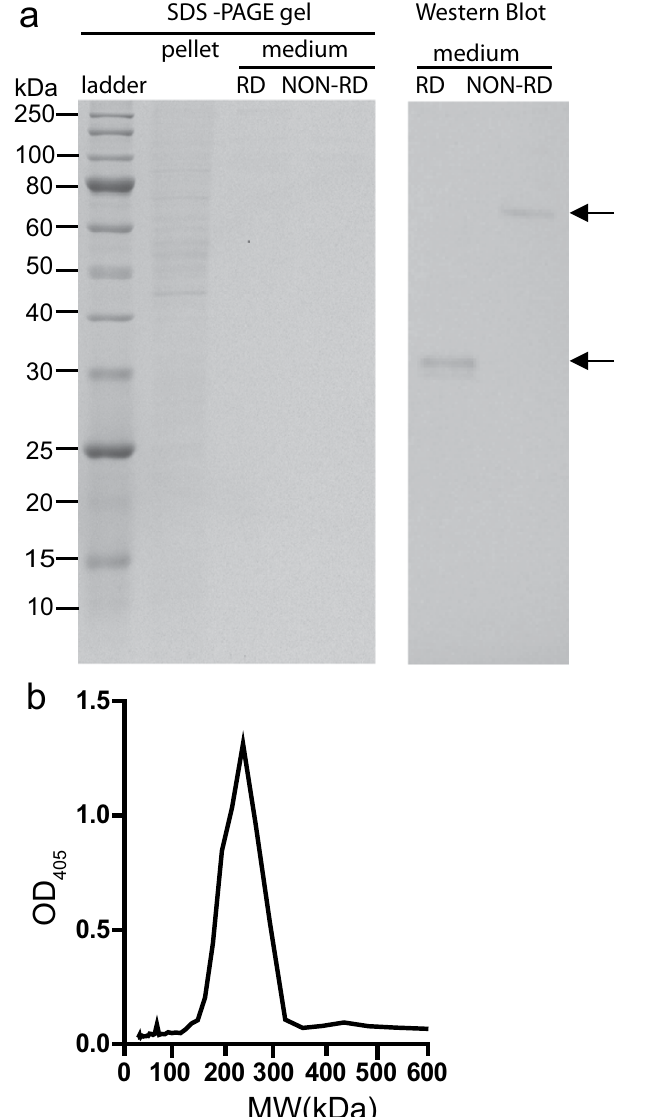
Figure 1. FBN30 is secreted from insect Hi5 cells and forms octamers. ( a ) The non-reducing (NON-RD) (without β -ME) and the reducing (RD) conditions of 12% SDS-PAGE analysis were performed. FBN30 was detected with anti-FBN30 antibody. A specific band with a molecular mass of ~ 33 kDa (bottom arrow labeled, corresponding to insect cell expressed recombinant FBN30 protein) under reducing condition was detected from the medium (right panel), indicating that the recombinant FBN30 is a secreted protein. Under non- reducing conditions, a specific band of ~66 kDa (top arrow labeled) was detected with anti-FBN30, suggesting that FBN30 forms a homodimer through disulfide bond. ( b) The FBN30 protein from the concentrated medium was applied onto a size exclusion chromatography using a Superdex-200 increase column and the FBN30 in each eluted fraction was quantified with ELISA assays. The molecular mass of FBN30 ranged from 212– 274 kDa, suggesting that the native FBN30 exists as an octamer, which is formed by four disulfide-bond linked